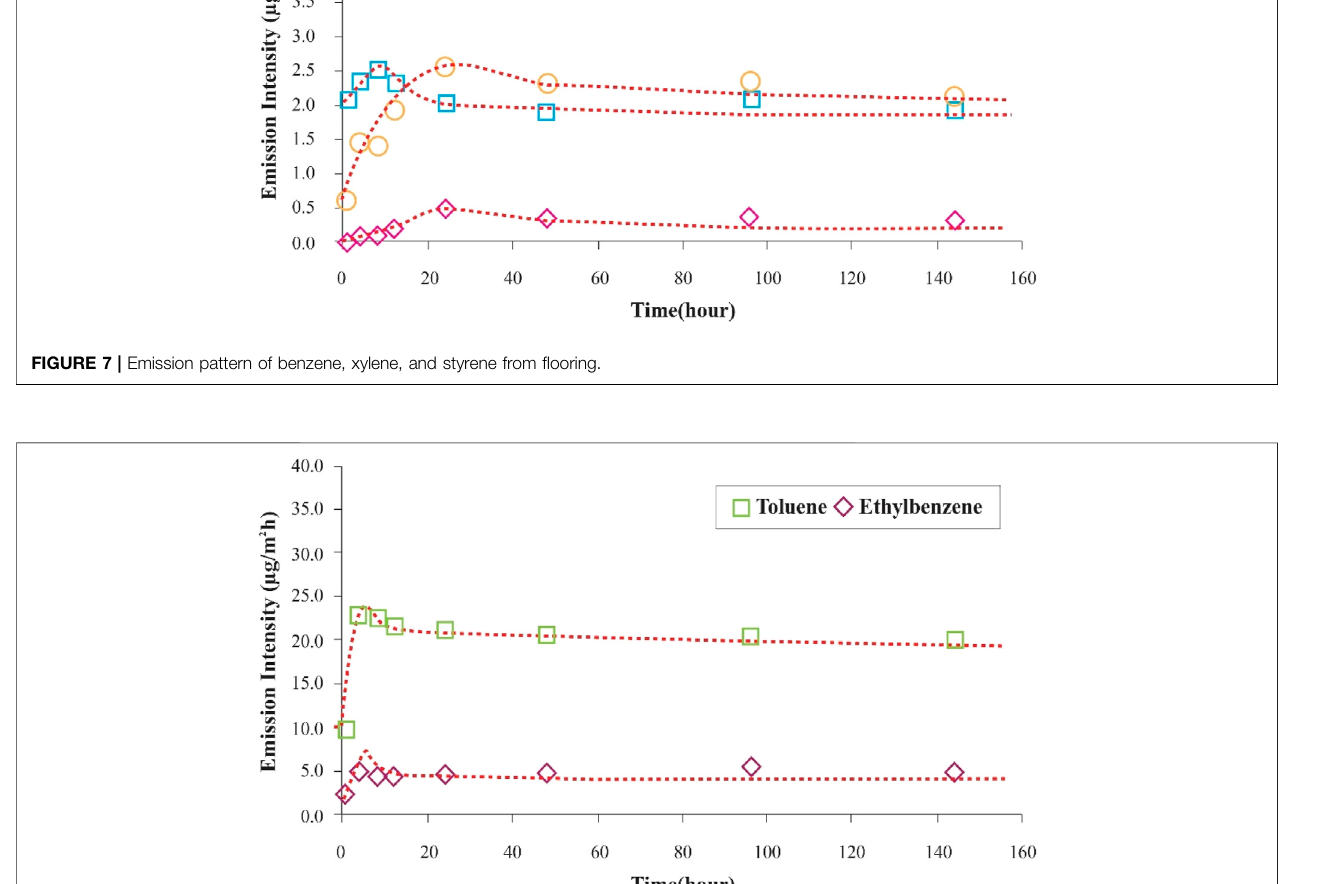
Frontiers in Built Environment |